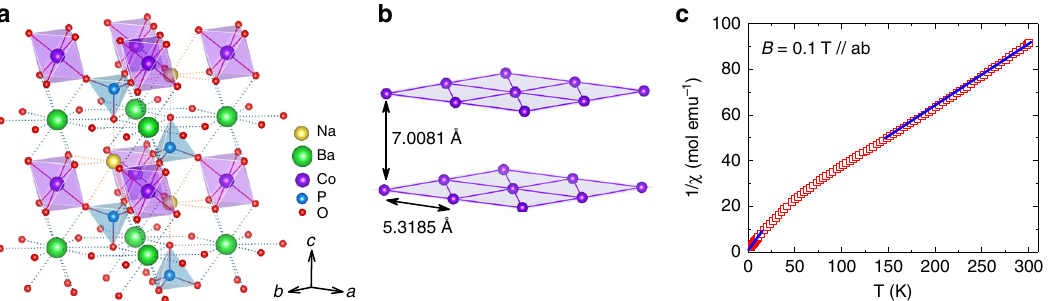
Fig. 1 Structure and magnetic susceptibility of Na 2 BaCo(PO 4 ) 2 . a The crystallographic structure. b The triangular lattice of Co 2 + ions in the ab plane. c The inverse of the DC susceptibility measured with 0.1 T magnetic fi eld along the ab plane. The solid lines are the Curie – Weiss fi ttings to high- temperature or low-temperature data.